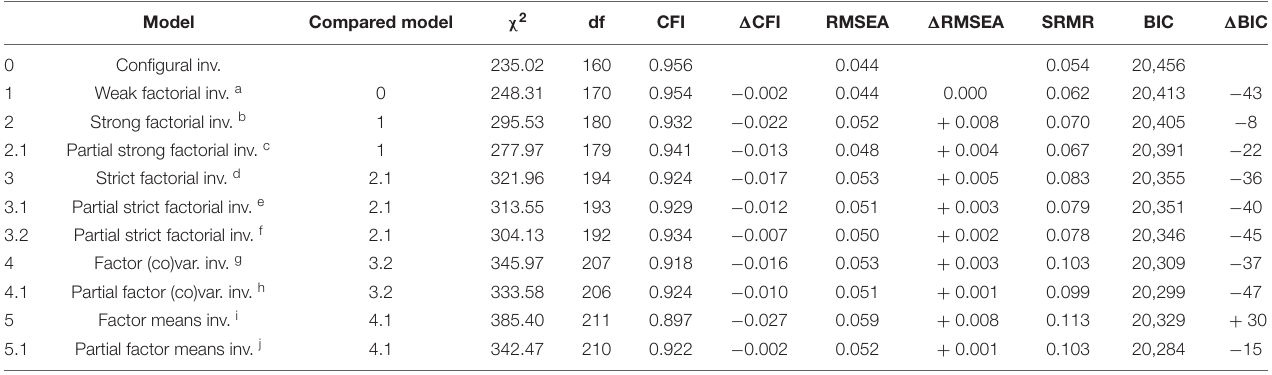
TABLE 2 | Measurement invariance models comparing the Italian and Belgian sample.